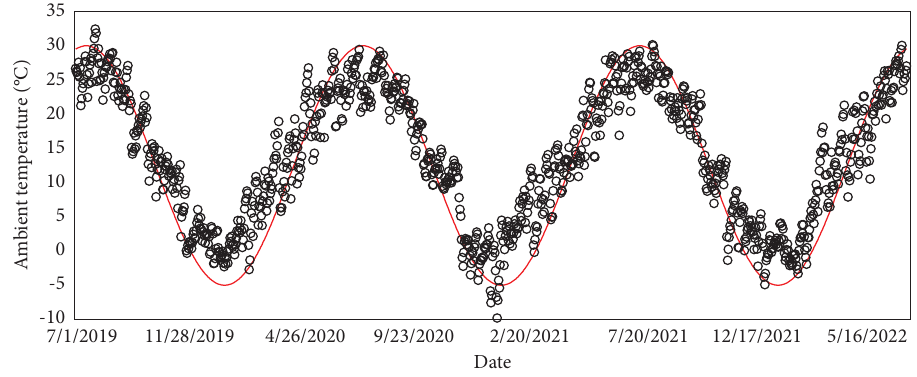
Figure 5: Approximated and measured ambient